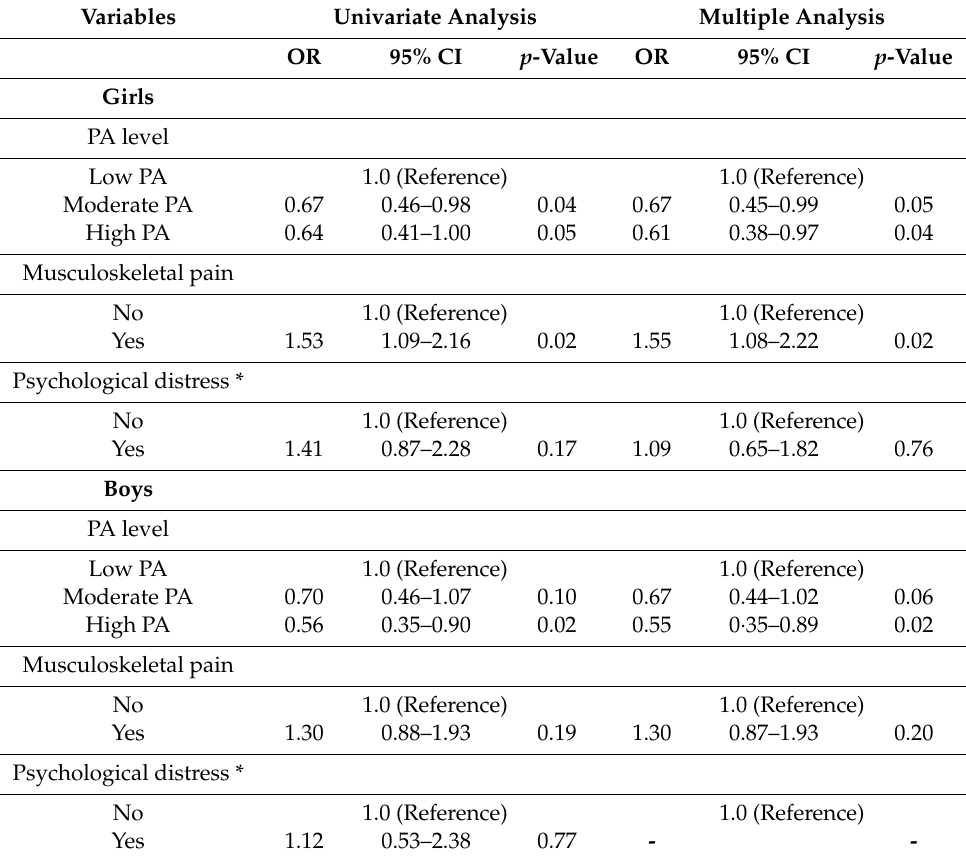
Table 2. Results from logistic regression analysis with obesity (BMI ≥ 30) in young adulthood as dependent